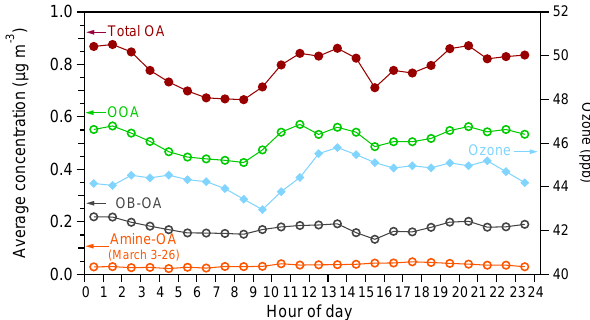
Fig. 8. Diurnal cycles of total OA and OA component concentra- tions (left vertical axis) and of the ozone concentrations (right ver- tical axis). Ozone and OOA follow similar diurnal cycles.